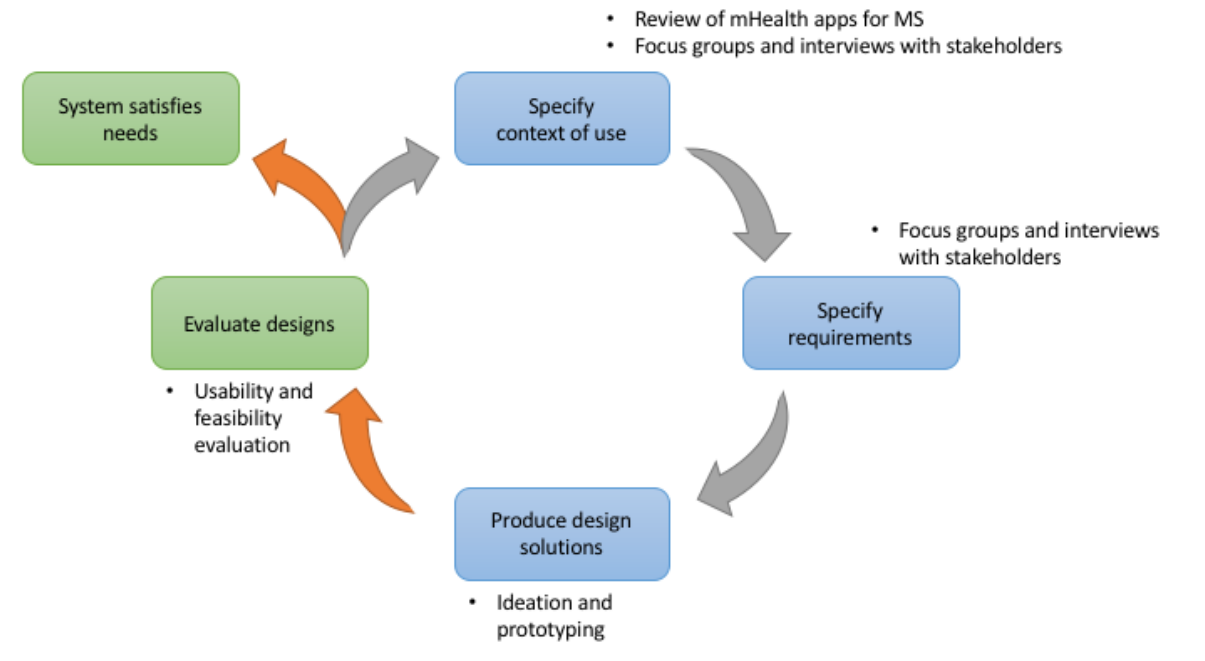
Figure 2. Phases of the user-centered design for the More Stamina app. The green boxes indicate the areas of focus for the current study. mHealth: mobile health; MS: multiple